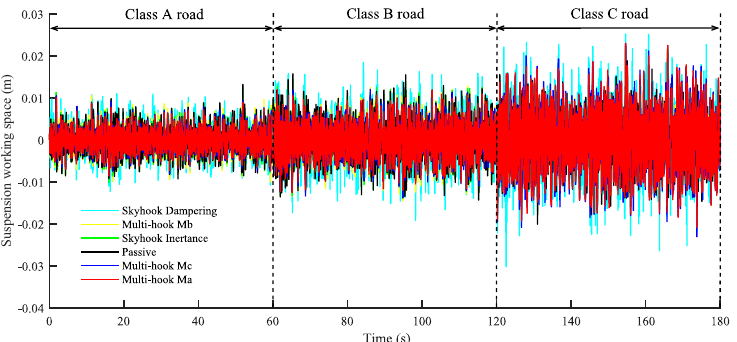
Figure 8. Time response comparison of suspension working space for single-skyhook and multi-hook control